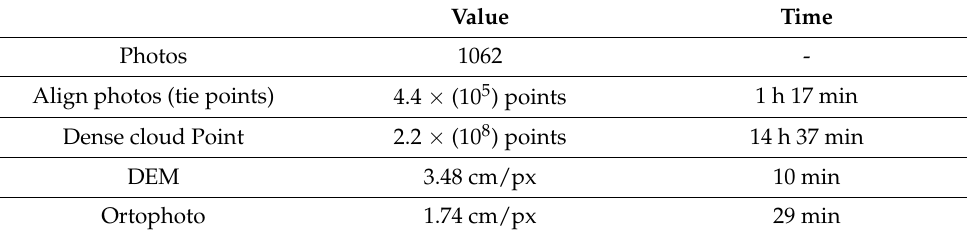
Table 2. Results of the workflow performed using Agisoft Metashape software. Value Time Photos 1062 - Align photos (tie points)